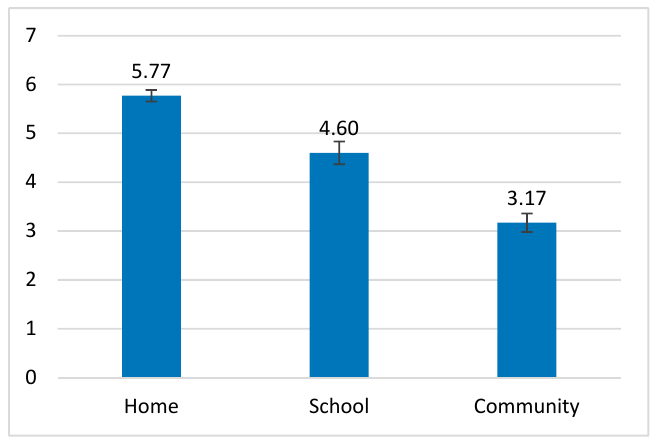
Figure 4. Frequency of participation of the ADHD group in the three settings.